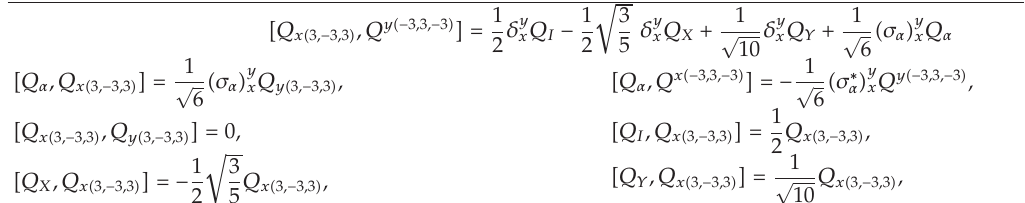
i are the Pauli matrices.